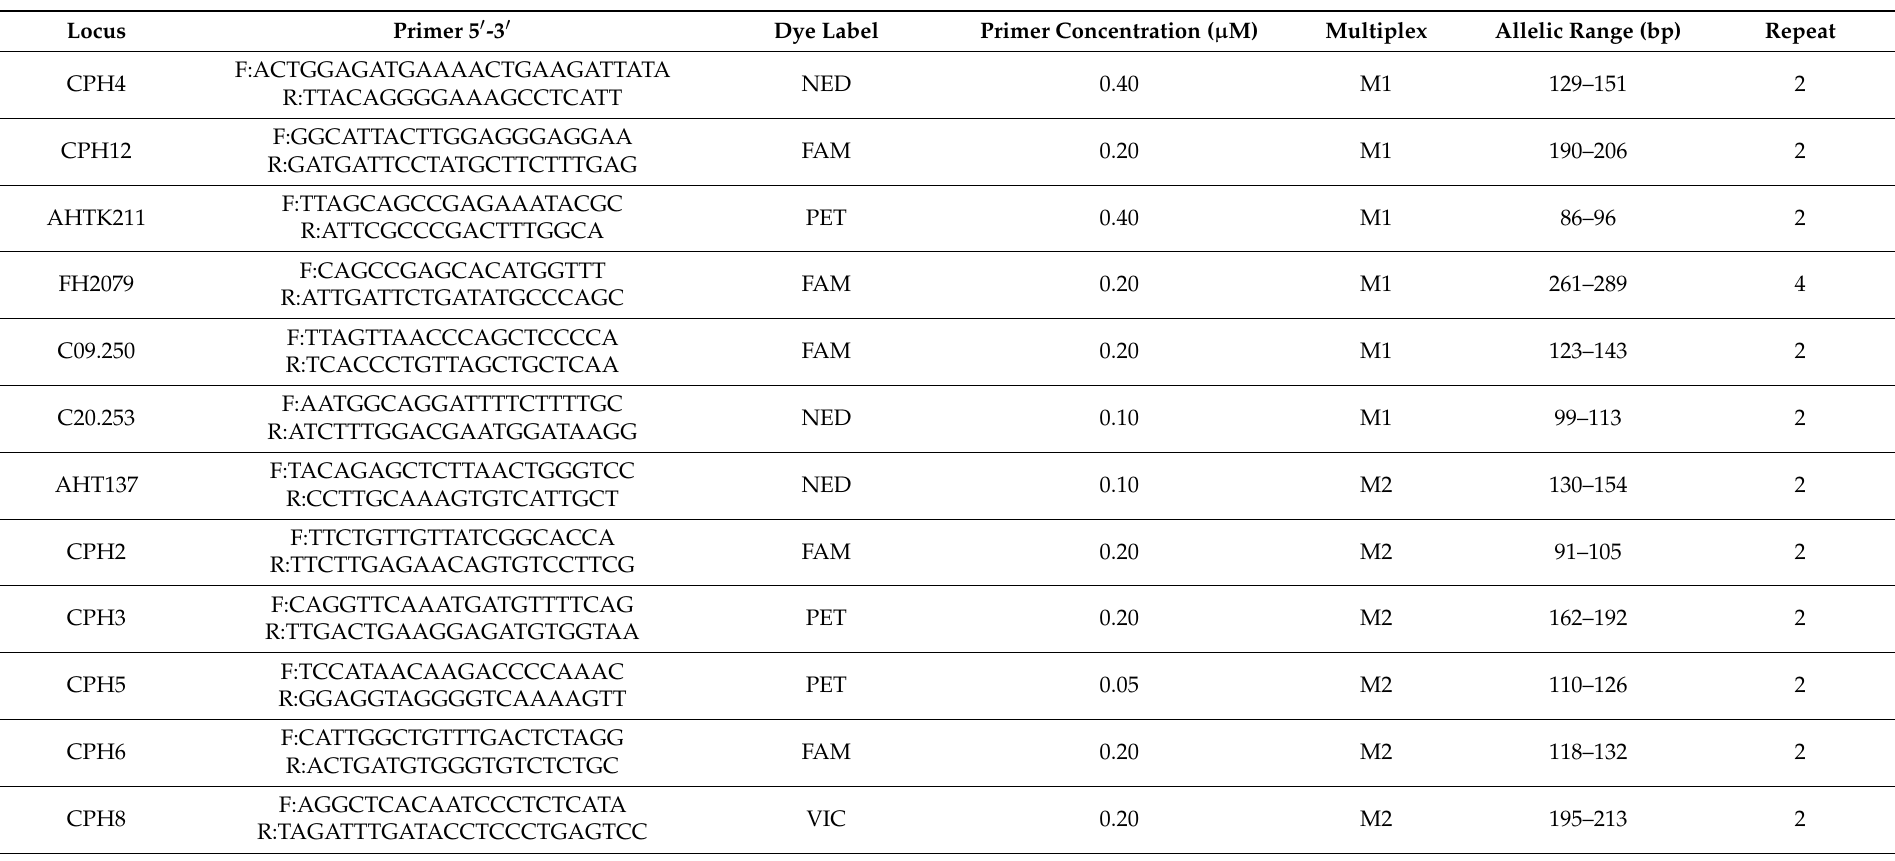
Table 1. STR loci, primer sequences, fluorescent dye labels at 5 (cid:48) of the forward primer, final concentration of forward and reverse primers in their